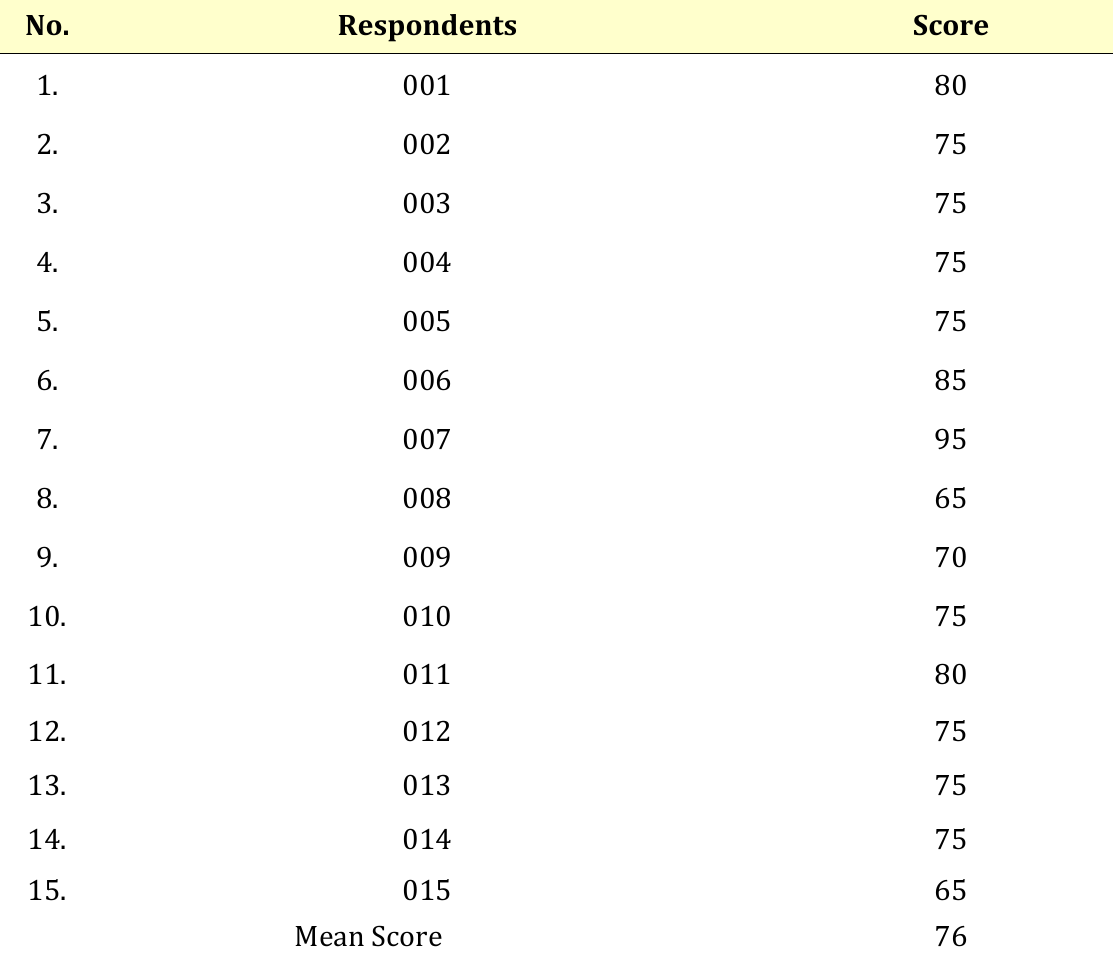
Table 6. The result of the test in cycle